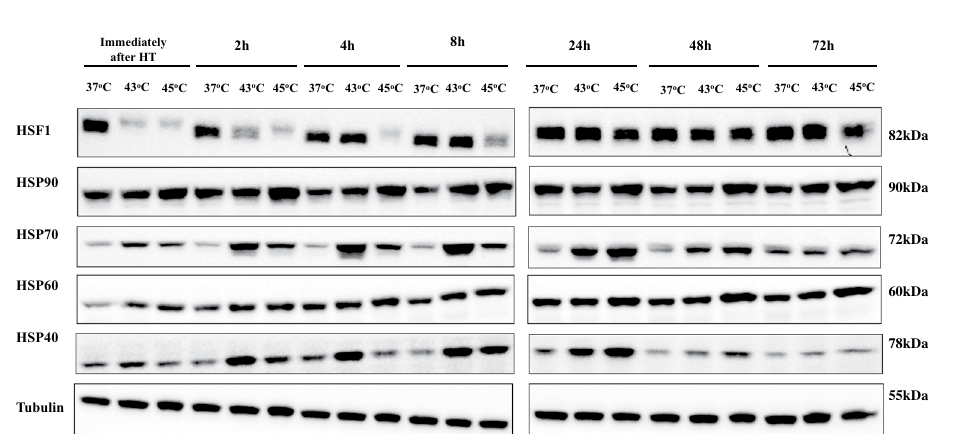
Figure 6. Hyperthermia-induced regulation of heat shock proteins in human malignant melanoma (A375) cells. The effect of hyperthermia on protein content of HSF1, HSPs 90, 70, 60 and 40. Cells were grown overnight at 37 °C followed by exposure to hyperthermia, for 2 h, and then transferred back to 37 °C for the indicated post-exposure incubation times (2–72 h). Cell lysates were prepared and subjected to western blotting. Control cells were kept at 37 °C. β -tubulin was used as loading control. Samples from short and long-post exposure incubation periods following hyperthermia were electrophorized on separate gels. Delineation shows blots cropped from different areas of the same blot or different blots. Data shown is representative of at least two independent